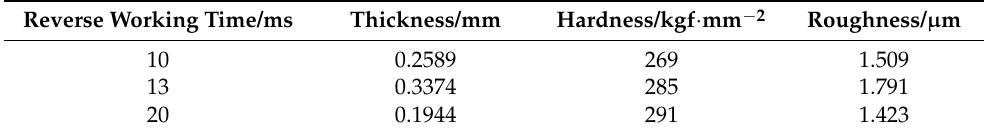
Table 2. Results of the effect of changes in reverse working time on the properties of composite plating.